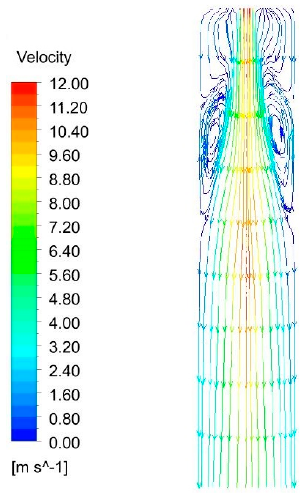
Figure 3. Velocity contour on the symmetry plane.